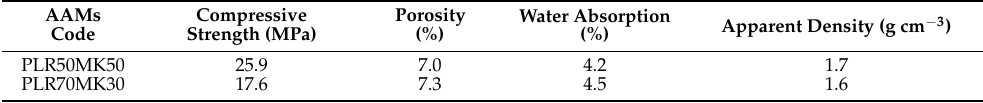
Table 6. Physical properties of selected AAMs 1 .